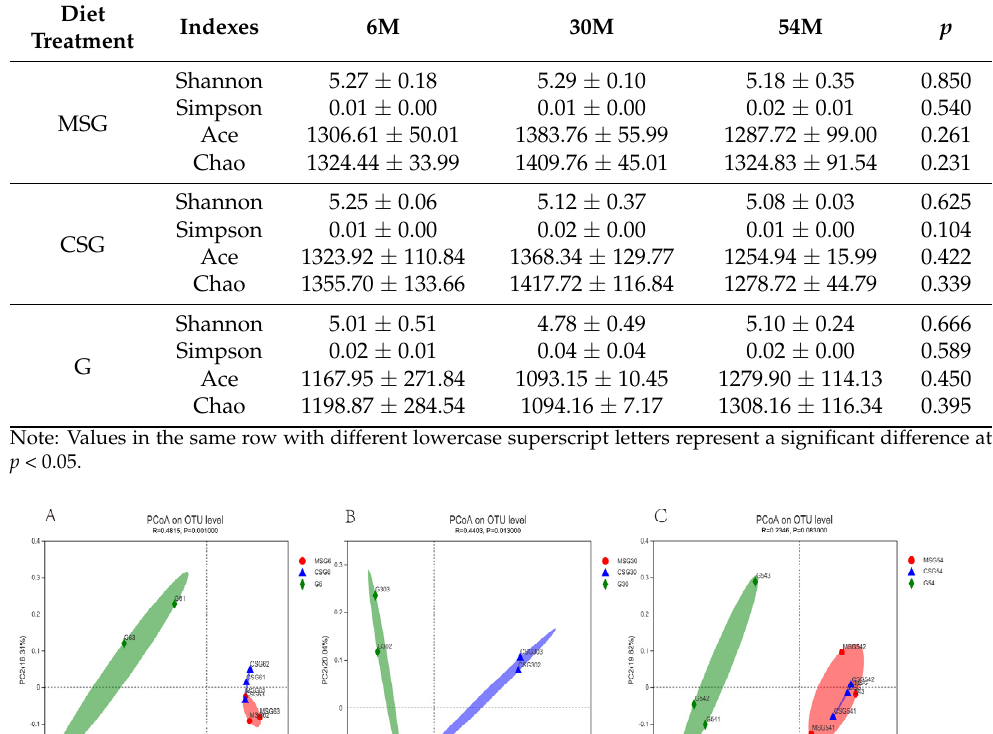
Figure 3. Microbial composition in the rumen of yaks at the phylum level.